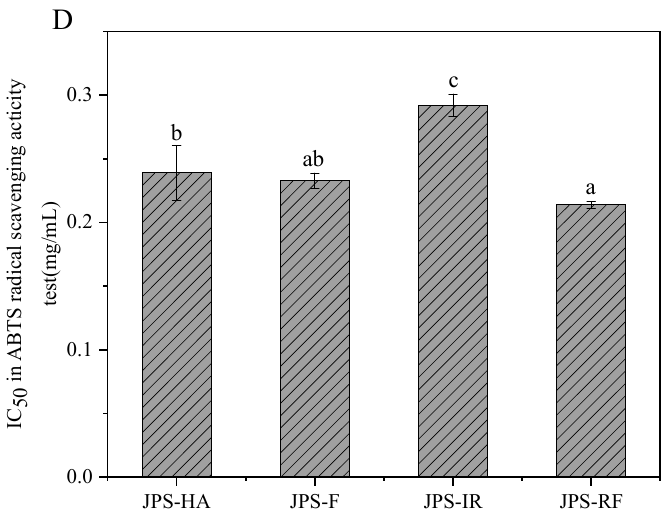
Figure 4. Effects of different drying methods on the antioxidant ability of JPSs. DPPH radical- scavenging activity ( A ) and its IC 50 value ( B ); ABTS radical-scavenging ability ( C ) and its IC 50 value ( D ). Bars with different letters differ significantly ( p < 0.05).